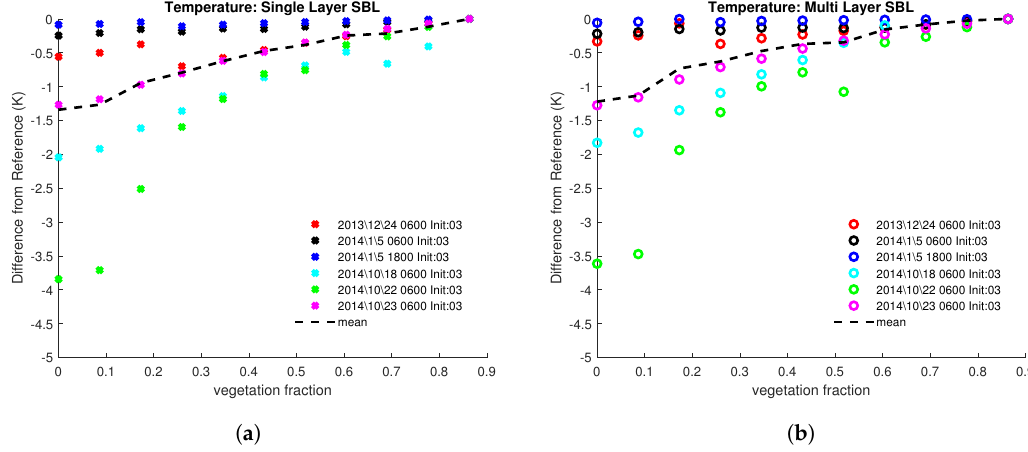
Figure 7. Percent difference of temporally averaged 117 m temperature from the 86.3% vegetation case as a function of vegetation percentage for single layer SBL ( a ) and multilayer SBL scheme ( b ). The black dashed lined indicates the mean for each vegetation